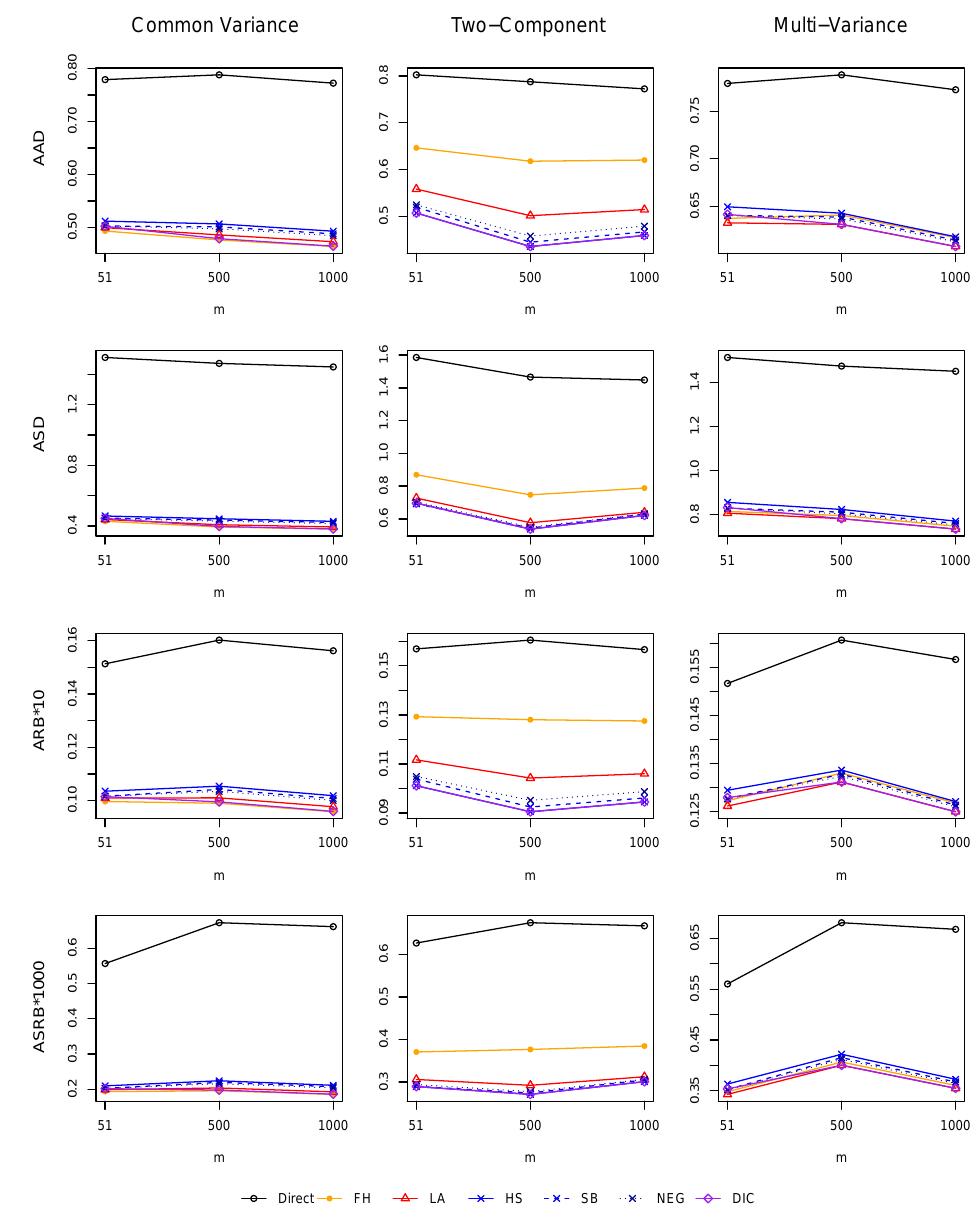
Figure 3. Average deviation measures for different models under different data generation settings in the simulation